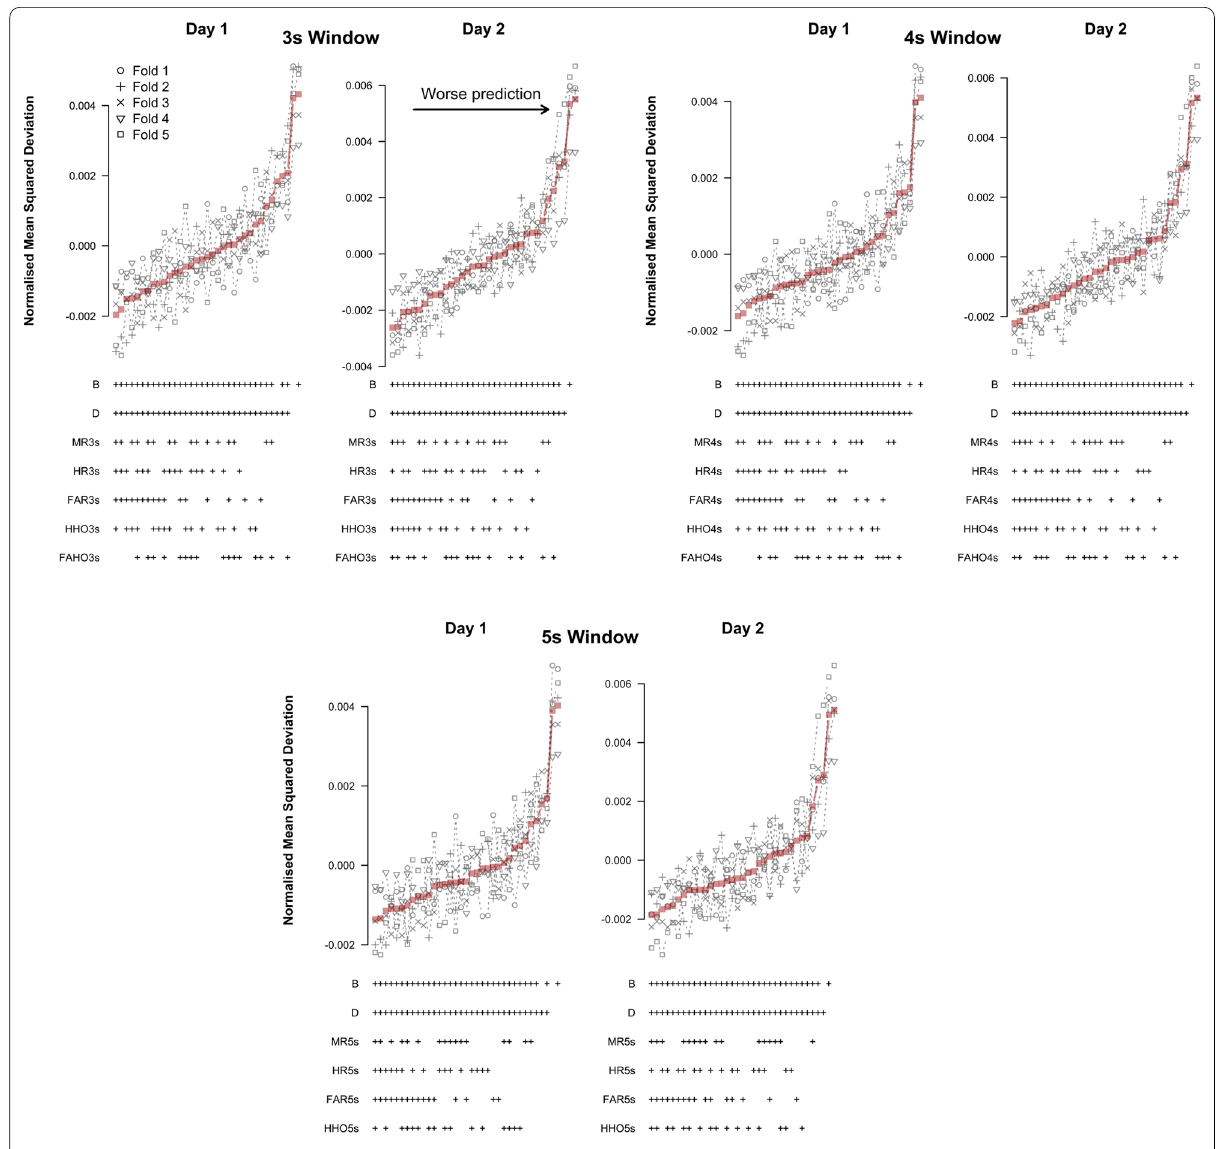
Fig. 7 Cross-validation results based on TPMs for different UAV-task event predictors of log-RT. Normalized mean squared deviations for different LMMs for different time windows prior to the DRT prompt are shown. Top row: 3-s time window; middle row: 4-s time window; bottom row: 5-s time window. Left column: results for day 1; right column: results for day 2. Red squares show the mean across